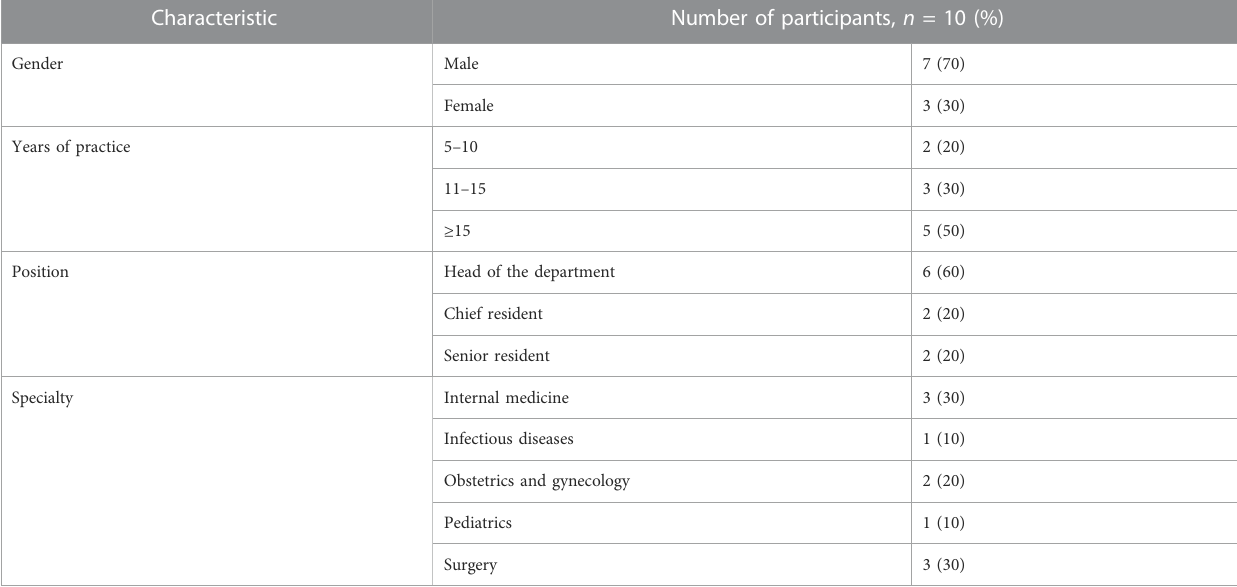
TABLE 5 Characteristics of